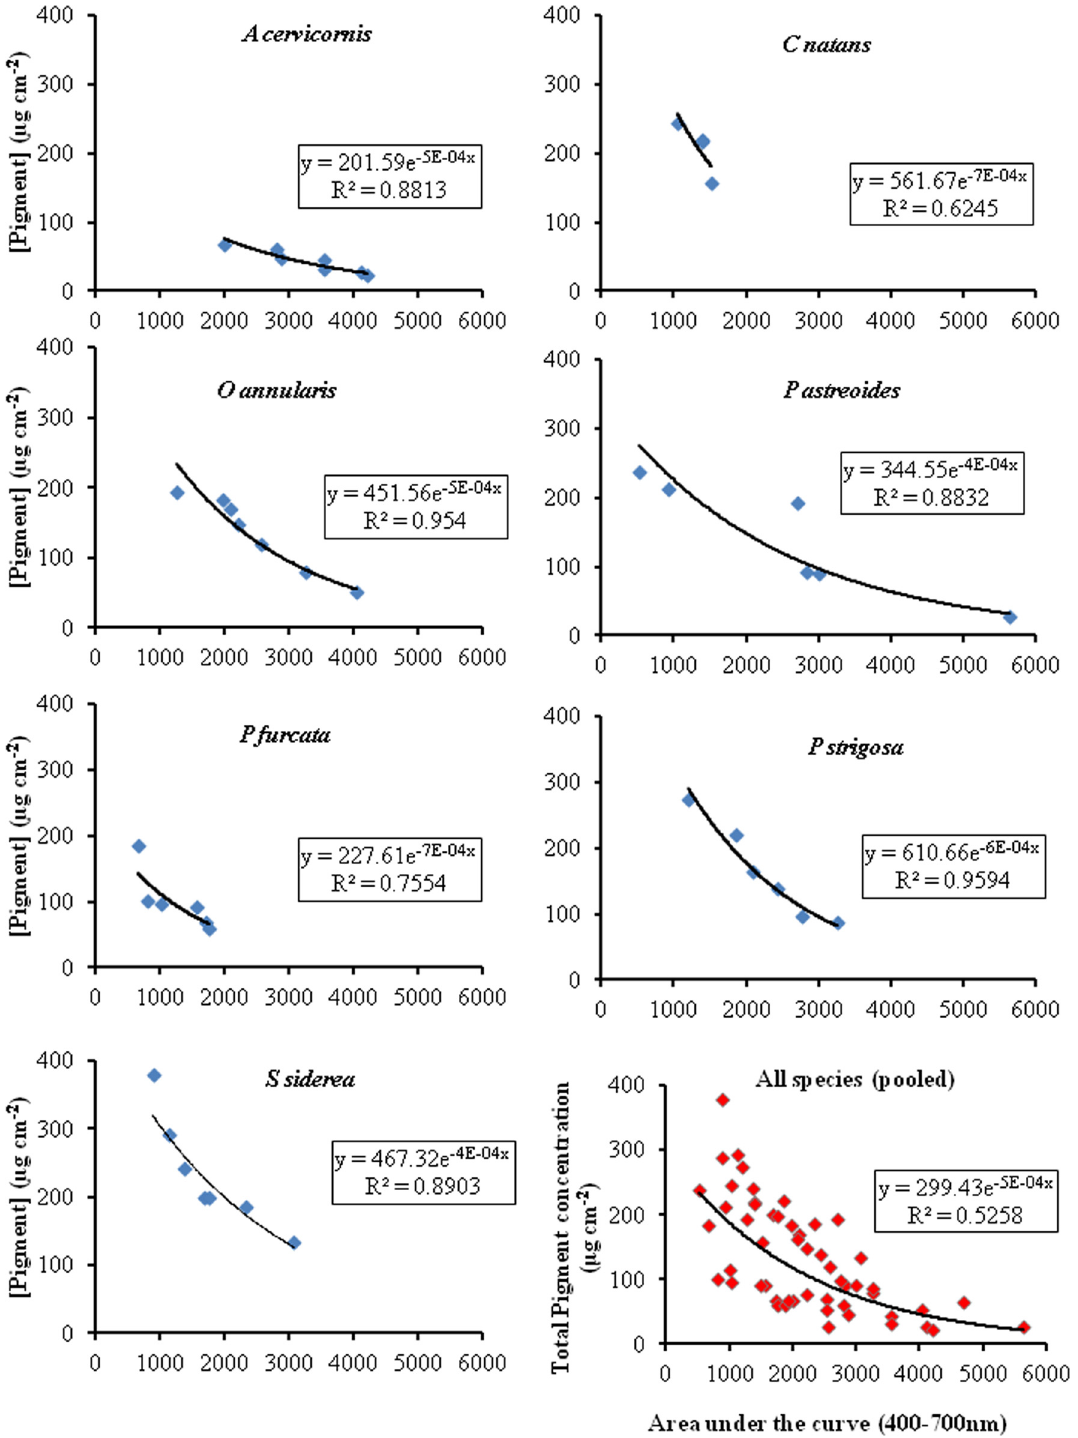
Fig 7. Relationship between the area under the reflectance curve and total pigment concentration (symbiont + other contributors). The x-axis represents the integration of the reflectance curve from 400 – 700 nm. The lower right graph shows the pooled data from all seven species.